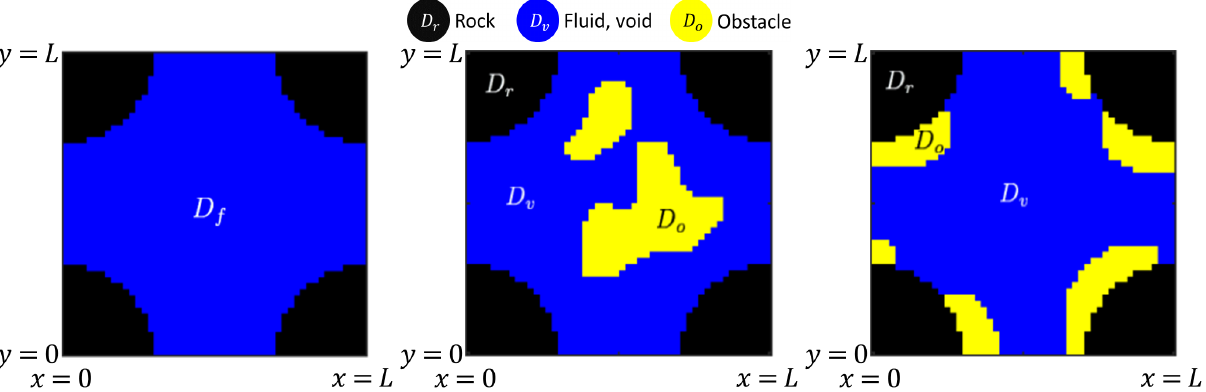
Figure 4. Single pore geometry with M = 50 × 50 voxels. Left: unobstructed pore with D o = ∅ , and D f = D v . Middle: pore-filling obstructions D o (hydrate-like). Right: pore-coating obstructions D o